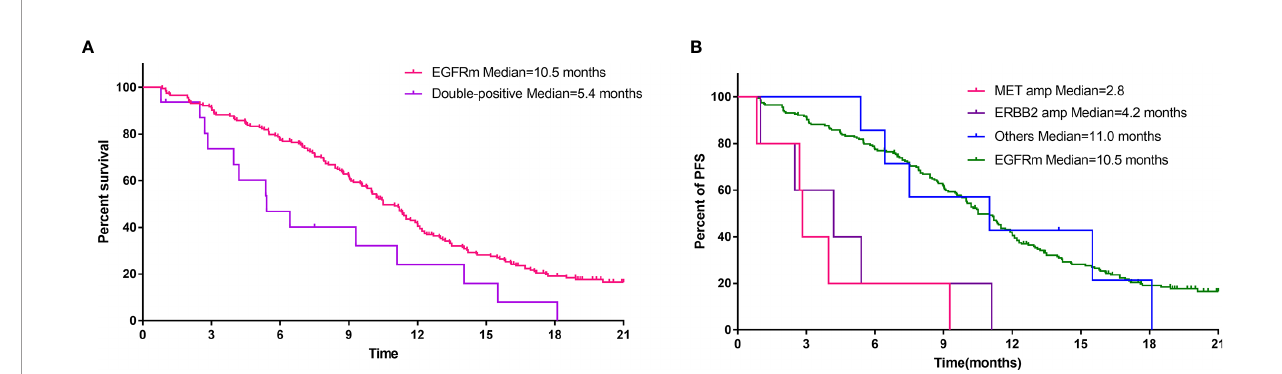
FIGURE 2 | (A) Comparison of PFS of fi rst-generation EGFR TKIs for patients with EGFR mutations alone and patients harboring both EGFR mutations and other potentially actionable oncogenic drivers. (B) PFS of fi rst-generation EGFR TKIs for EGFR -mutant patients with concurrent MET ampli fi cation, ERBB2 ampli fi cation, and other oncogenic drivers.